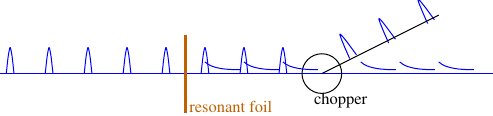
FIG. 6. Schematic of a spectral converter to isolate a single comb